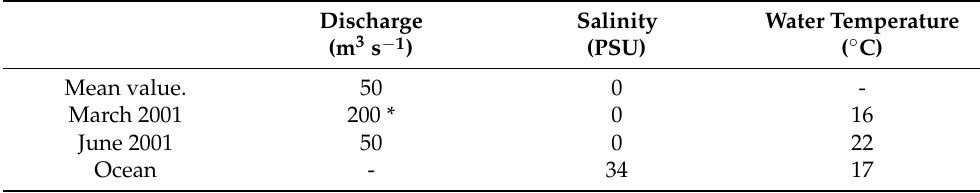
Table 2. Freshwater and ocean boundary conditions (discharge values for the main river, the Vouga).